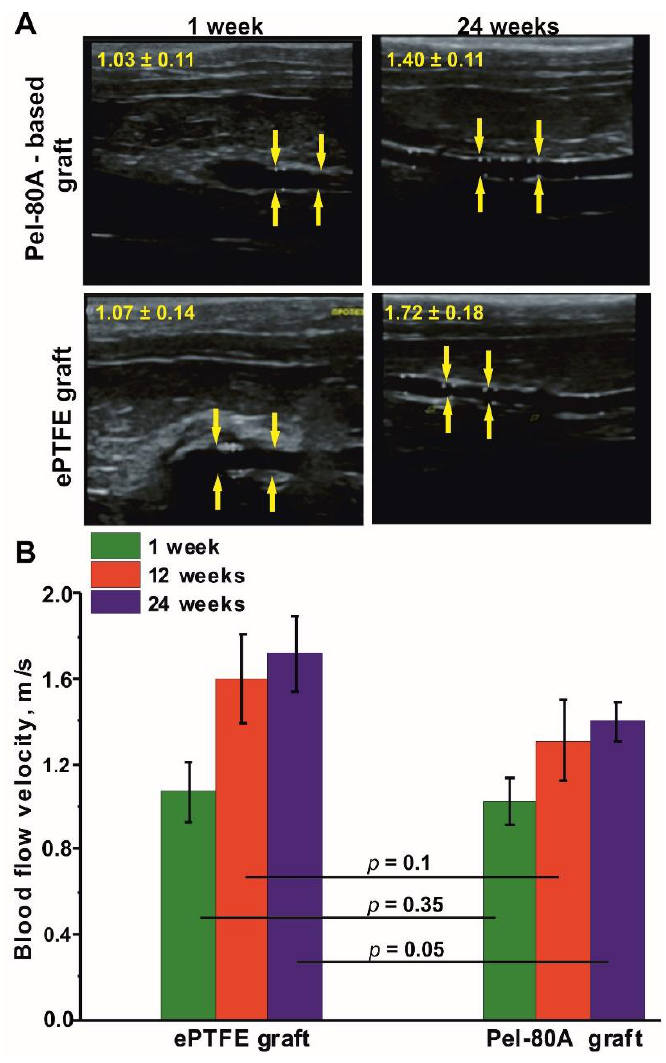
Figure 5. Images from ultrasound examination of vascular grafts ( A ). Blood flow velocity in tested VGs, n = 6 ( B ). Blood flow velocity of rat aorta is =1.06 ± 0.13 m/s. Anastomose zones are marked by yellow arrows.